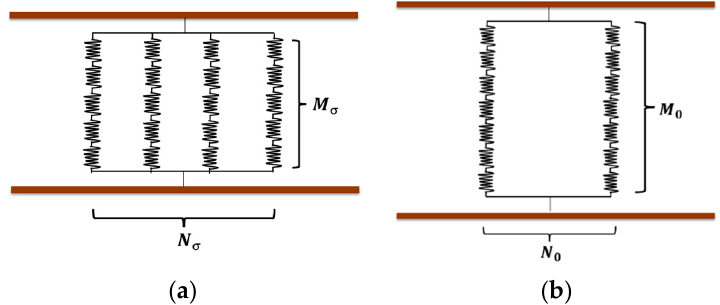
Figure 4. Piezoresistive effect for composites. ( a ) Equivalent circuit without compression and ( b ) equivalent circuit with compression. ( b ) equivalent circuit with